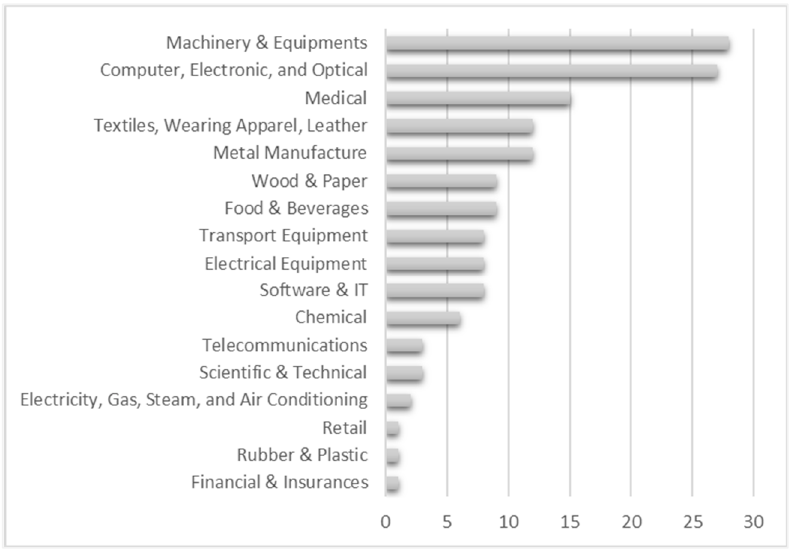
Figure 4. Industry sectors.